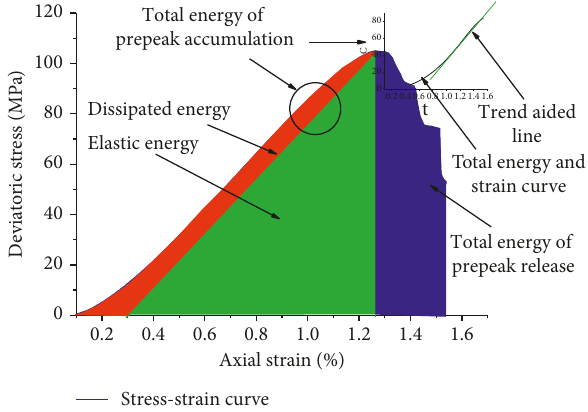
Figure 5: SZ-20 characteristics of energy